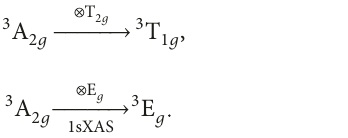
term is not reachable. 2 g